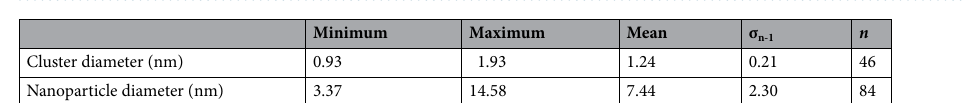
Figure 4. acSTEM-MAADF images of ( a ) visible Fe-clusters, appearing in light grey (examples highlighted with red arrows), embedded in a Fe-rich layer covering a grunerite particle extracted from AECs (white part of the image on the left); ( b ) amorphous Fe-rich nanoparticles (examples highlighted with red arrows) surrounded by Fe-rich material covering an anthophyllite particle (white part on right side of image) extracted from AECs. The two diagrams ( c , d ) show simplified cross-section models of an amphibole particle after its interaction with the AECs. ( c ) Crystalline amphibole (dark blue, representing the “bulk”), which is completely covered by the SiRA (light blue) and an outermost Fe-rich amorphous layer (orange) with embedded amorphous Fe-rich nanoparticles; ( d ) Crystalline amphibole whose Fe-rich layer (light orange) is discontinuous and heterogeneously covers the underlying SiRA.